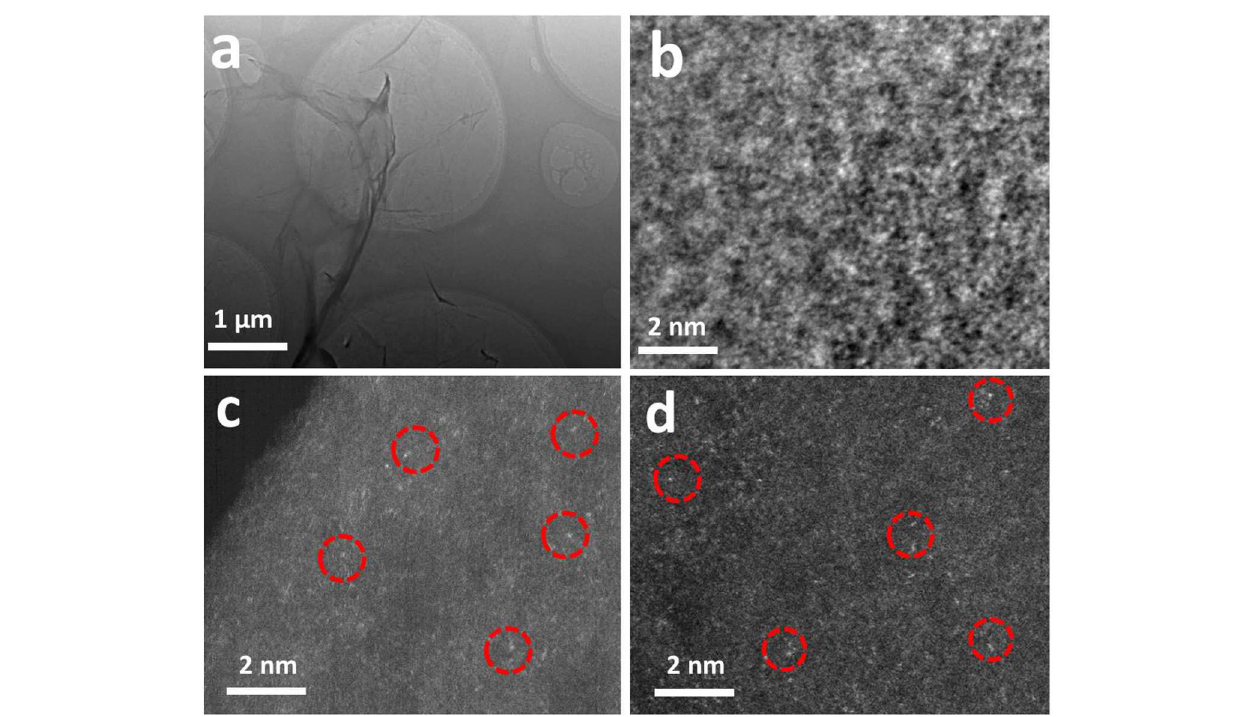
FIGURE 2 | (a) TEM image of Ni 4 Fe 1 -O-G SACs. (b) HRTEM image of Ni 4 Fe 1 -O-G SACs. (c,d) Magnified HAADF-STEM images of Ni 4 Fe 1 -O-G SACs. The single Ni, Fe atoms were marked with red circles.